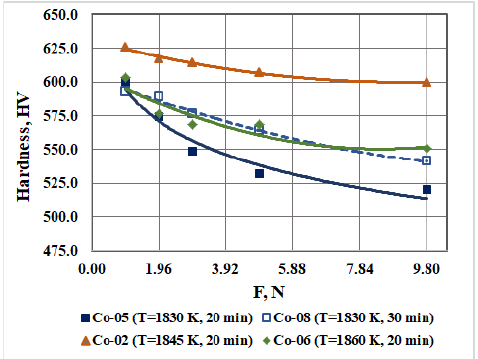
Figure 4. Influence of the EBMR technological parameters on the hardness of the obtained CoCrMo samples under different loads.